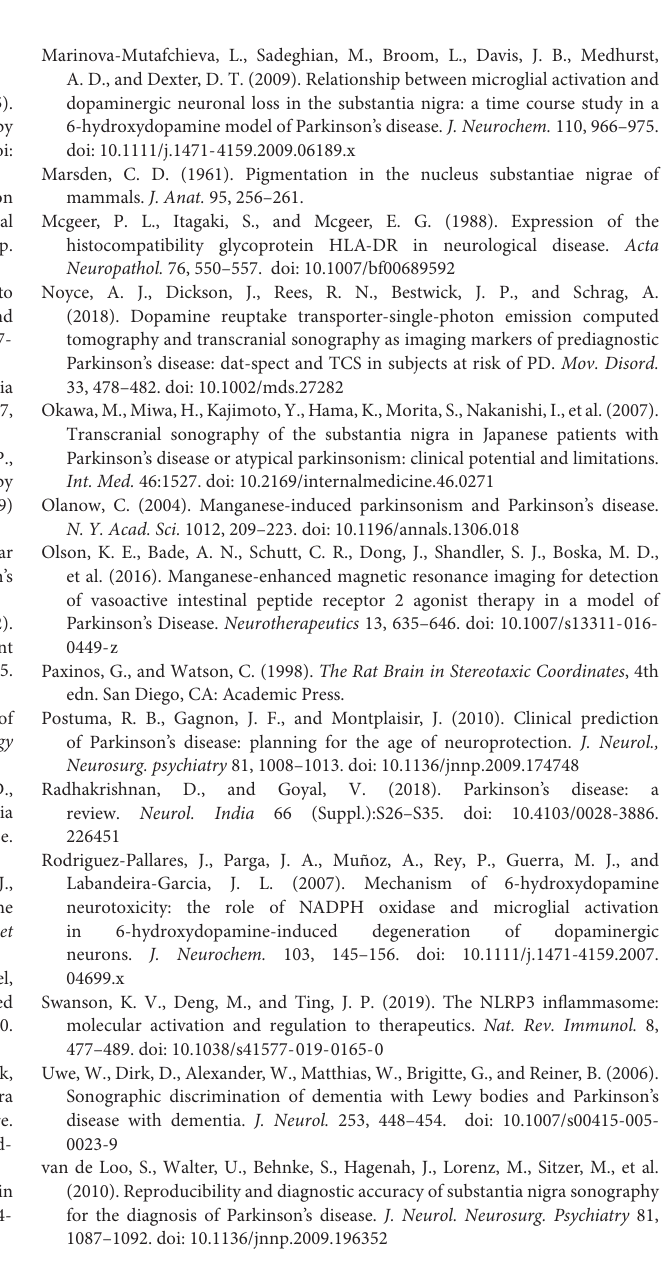
FIGURE S1 | Evaluation of stereotactic 6-hydroxydopamine (6-OHDA) injection in the Parkinson’s disease rat model. (A) Dopaminergic neurons were stained for immunofluorescence by tyrosine hydroxylase (TH) immunoreactivity. Scale bar depicts 300 µ m. (B) TH protein levels in the SN and the striatum of 6-OHDA-lesioned and vehicle rats. (C) The ratios of TH to total protein loading ( β -actin) are shown in the histogram ( t -test). Striatum of the vehicle group: